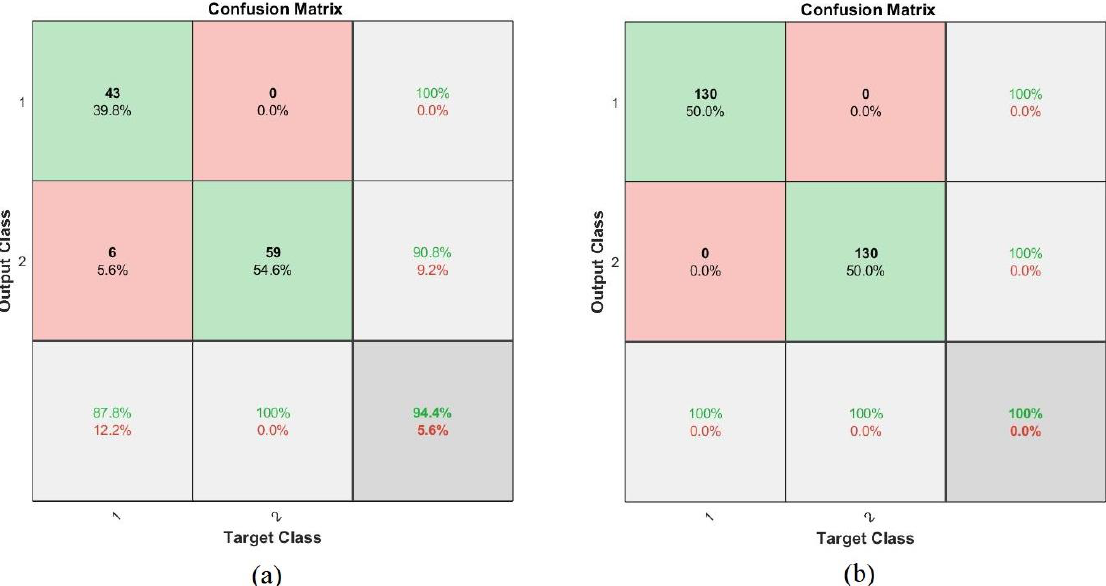
Figure 19. Confusion matrix for the FFNN algorithm of the ( a ) ALL_IDB1 and ( b ) ALL_IDB2 da- tasets. Table 2. The performance of the ANN and FFNN algorithms on the ALL_IDB1 and ALL_IDB2 da- tasets. Dataset